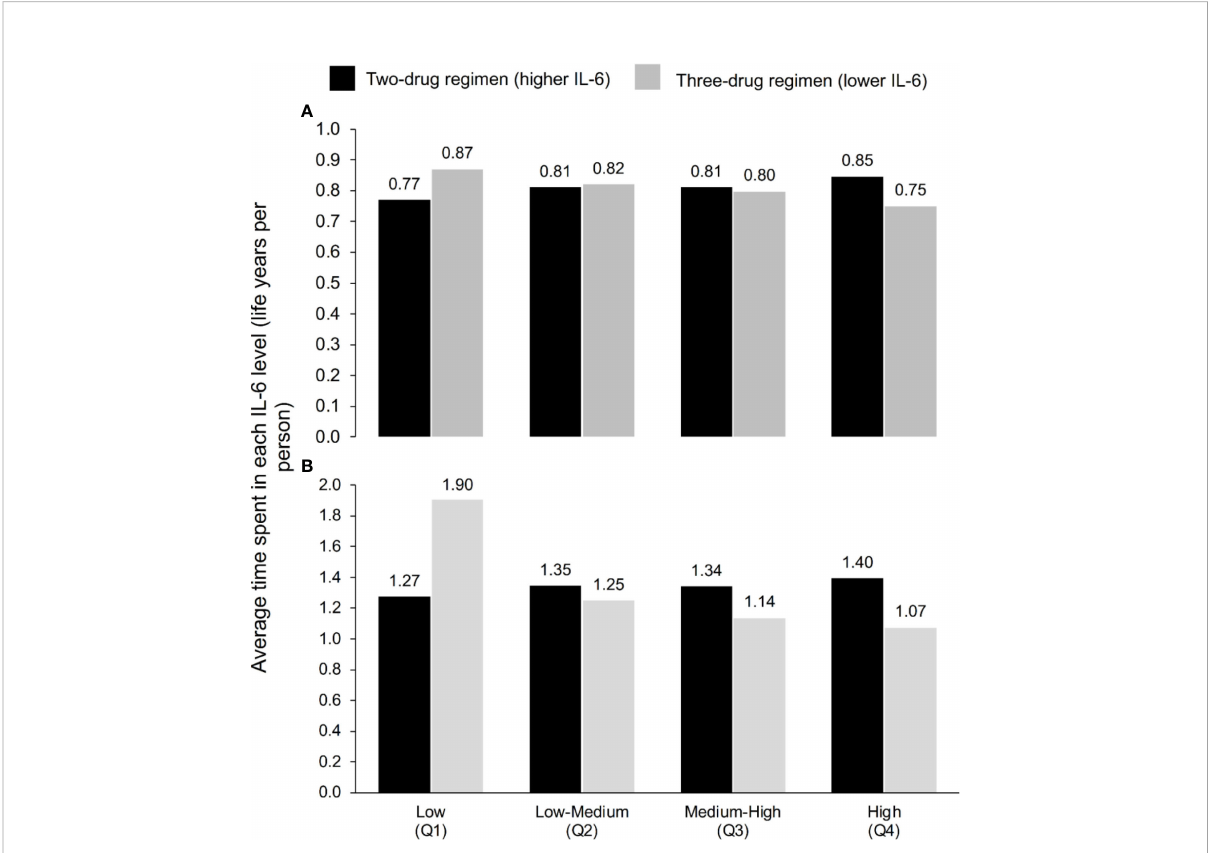
FIGURE 1 Average time spent in each IL-6 quartile according to ART regimen at (A) 3 years and (B) 5 years, according to the model, which used the IL-6 trajectories seen in TANGO (n=741, up to Week 144) and AIR (n=148, Weeks 144 –